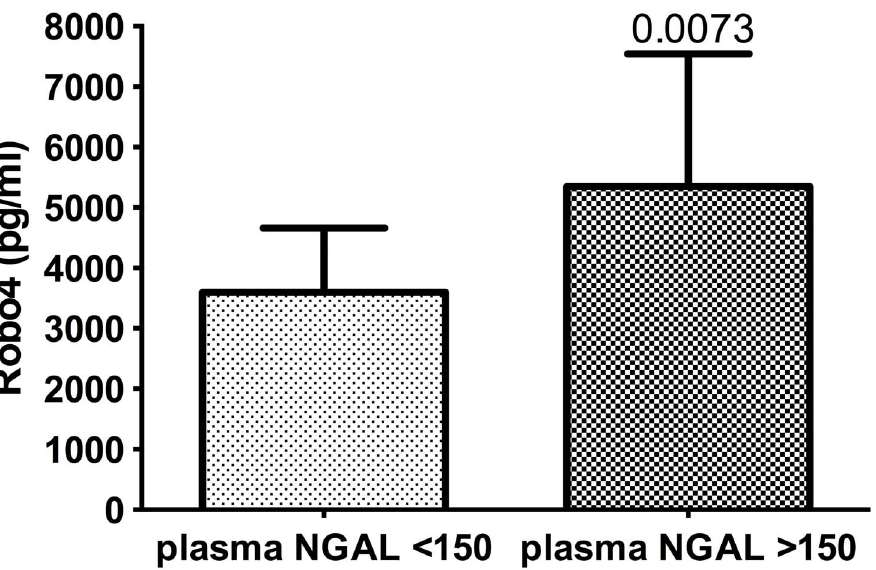
Figure 2. Plasma Robo4 levels in patients with or without AKI based on NGAL levels. Plasma levels of Robo4 in patients, 2 h post-cardiac surgery requiring cardiopulmonary bypass with or without acute kidney injury (AKI); assigned using plasma NGAL cut-off levels of 150 ng/ml. Data presented as bar graphs with mean and SD concentrations (pg/ml) of Robo4; n=16 (AKI), n=16 (non-AKI). doi:10.1371/journal.pone.0111459.g002 PLOS ONE |